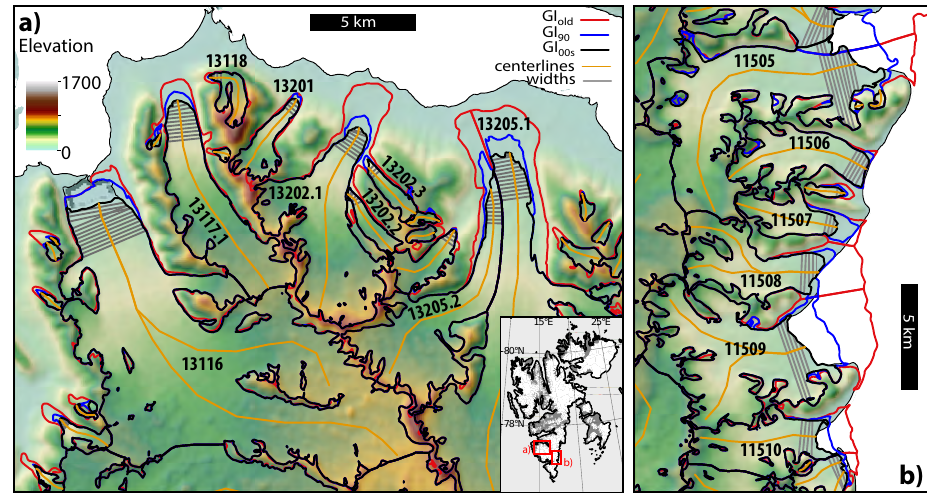
Fig. 3. Examples of the digital inventories from a selection of (a) land-terminating and (b) tidewater glaciers in southern Spitsbergen. Selected glaciers are shown with their local identification codes, centerlines and glacier tongue widths. Note that only centerlines and tongue widths from the lowest 10% of the centerline of the GI 00s are